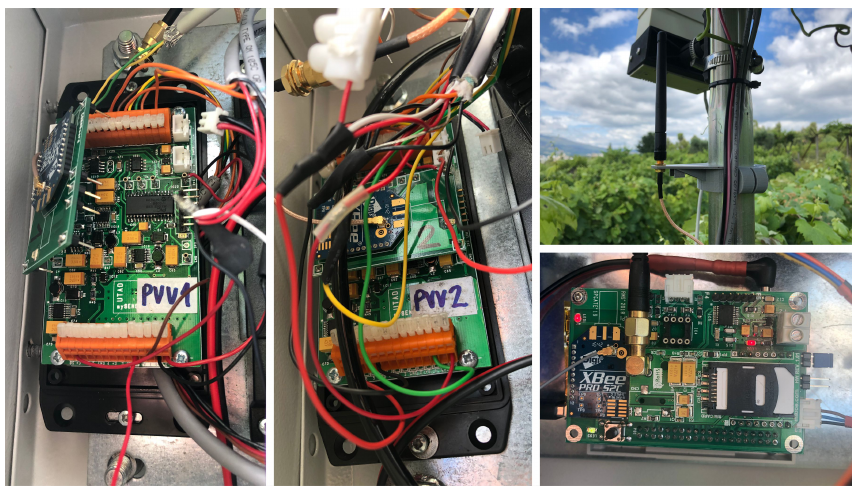
Figure 5. SPWAS’21 field evaluation prototypes. ( Left ) 2 XBee-based devices; ( Bottom-right ) Field gateway; ( Top-right ) Antenna location detail.